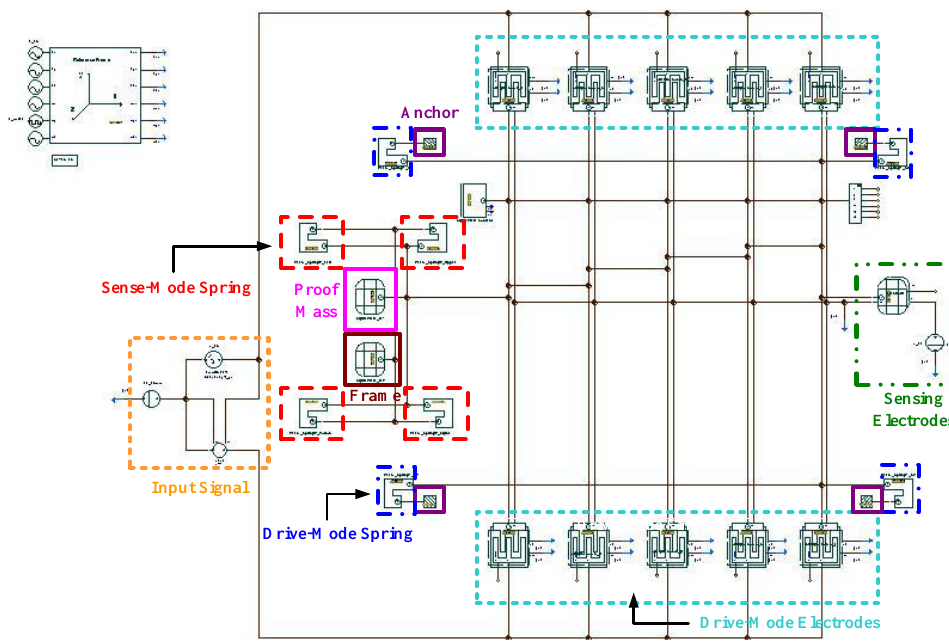
Figure 11. Schematic of out-of-plane SGDG.